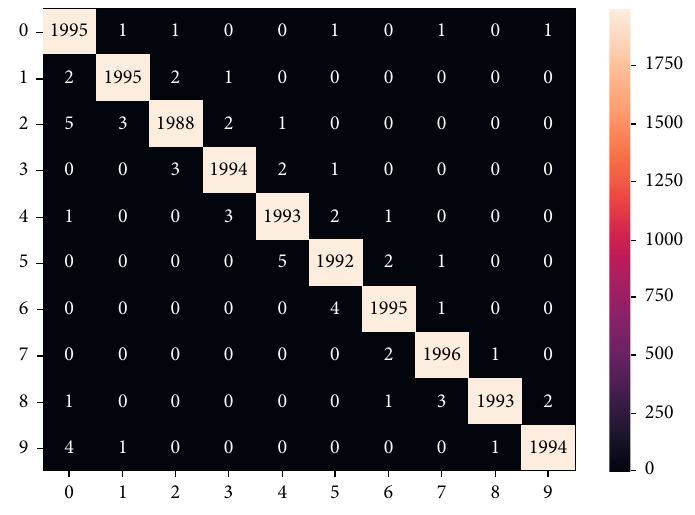
Figure 6: Confusion matrix for the RTD dataset. Table 2: Character-wise performance comparison between di ff erent datasets and algorithms. The accuracies are in